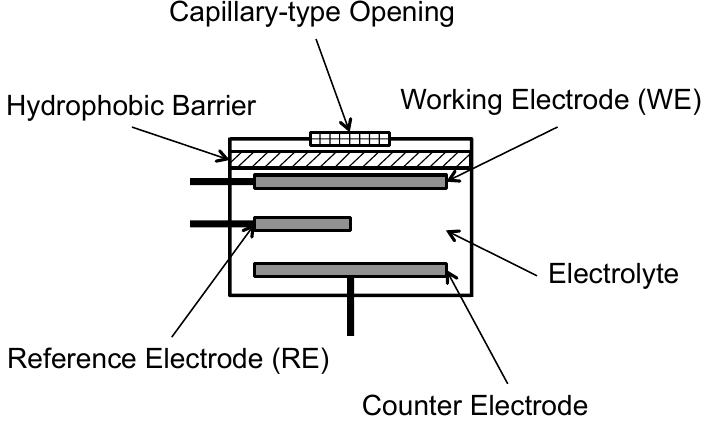
Figure 4. Basic Electrochemical